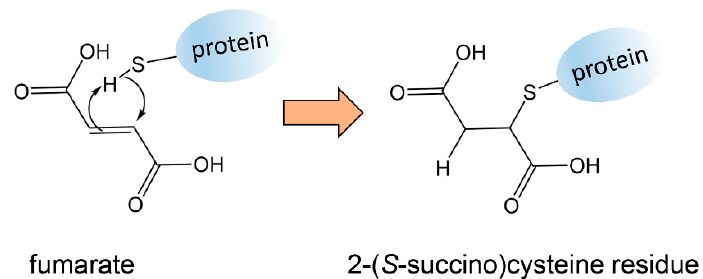
Figure 2. Reaction of protein thiols with elevated cellular fumarate by the Michael addition leading to succinated proteins. to succinated